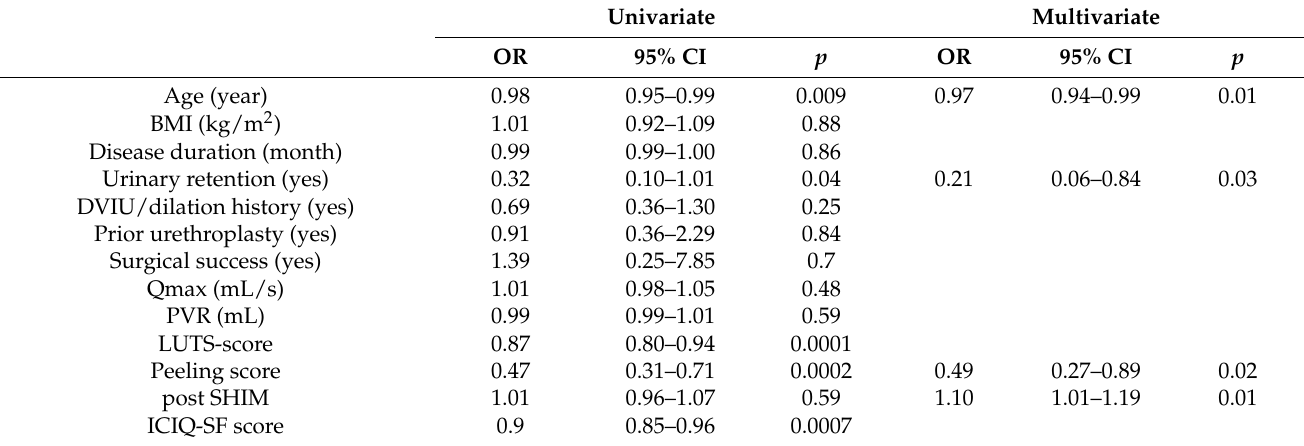
Table 9. Logistic regresssion analysis of predicting “very satisfied” patients.